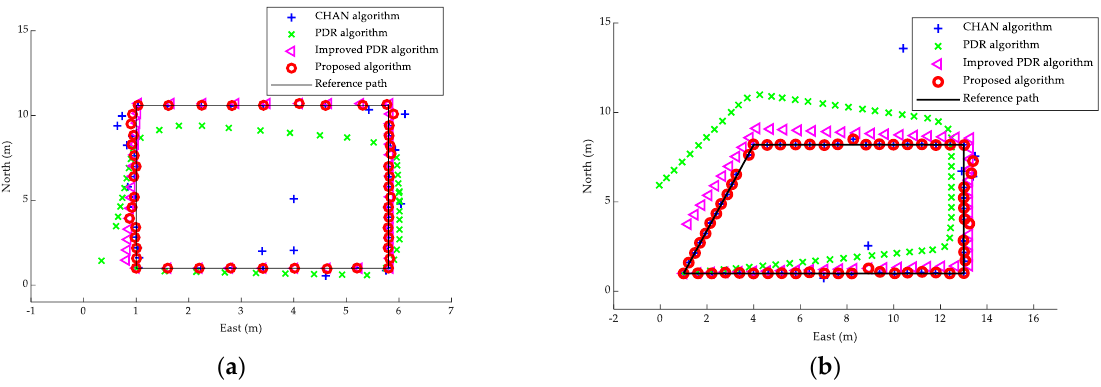
Figure 13. Localization path results among CHAN, PDR, dynamic improved PDR, and the proposed algorithm at the two scenes. ( a ) Volunteer #1 with a VivoY85a cell phone in the first scene. ( b ) Volunteer #2 with a VivoY85a cell phone in the second scene.